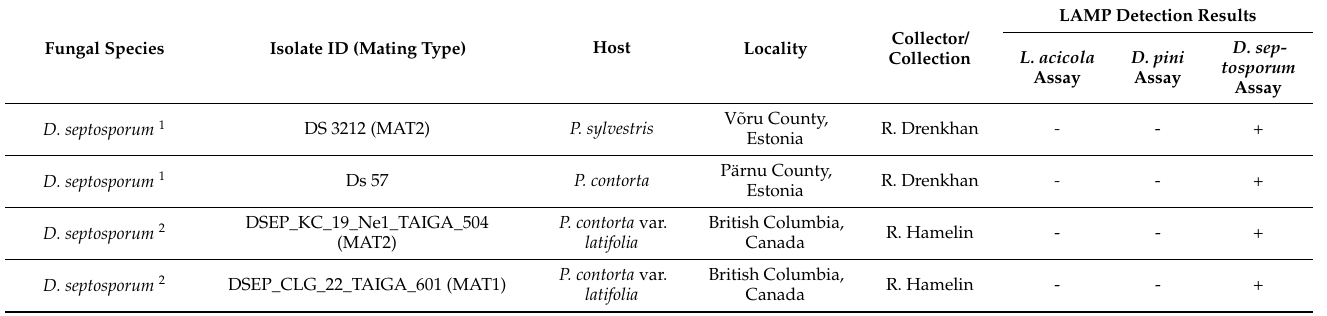
Table 1. Fungal isolates used to test the specificity of the Lecanosticta acicola, Dothistroma pini and D. septosporum species- specific loop-mediated isothermal amplification (LAMP)